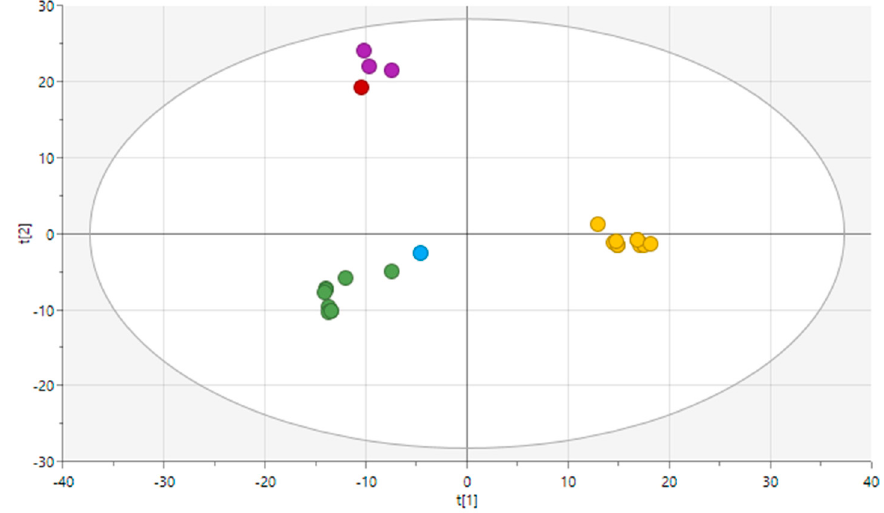
Figure 4. PCA analysis based on the functional annotation (KO copy number and prevalence) of strains from the clade Novacetimonas . A total of 1741 KOs were used. Legend: green, G. entanii ; blue, N. maltaceti ; purple, N. pomaceti ; red, N. cocois ; yellow, N. hansenii .